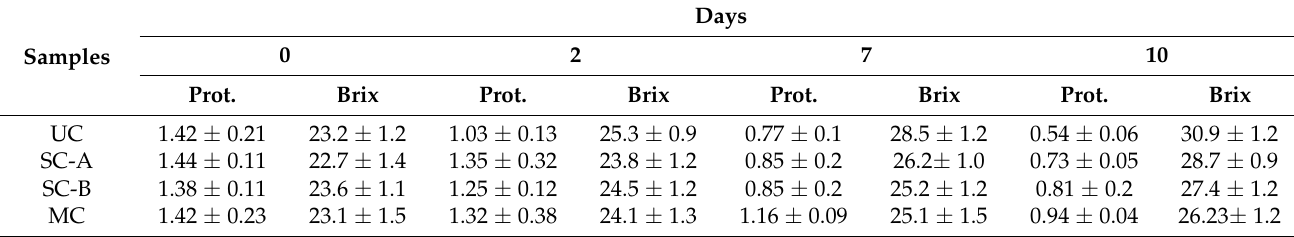
Table 1. Total soluble solid and protein content in uncoated and differently coated cherimoya samples during 10 days of preservation.